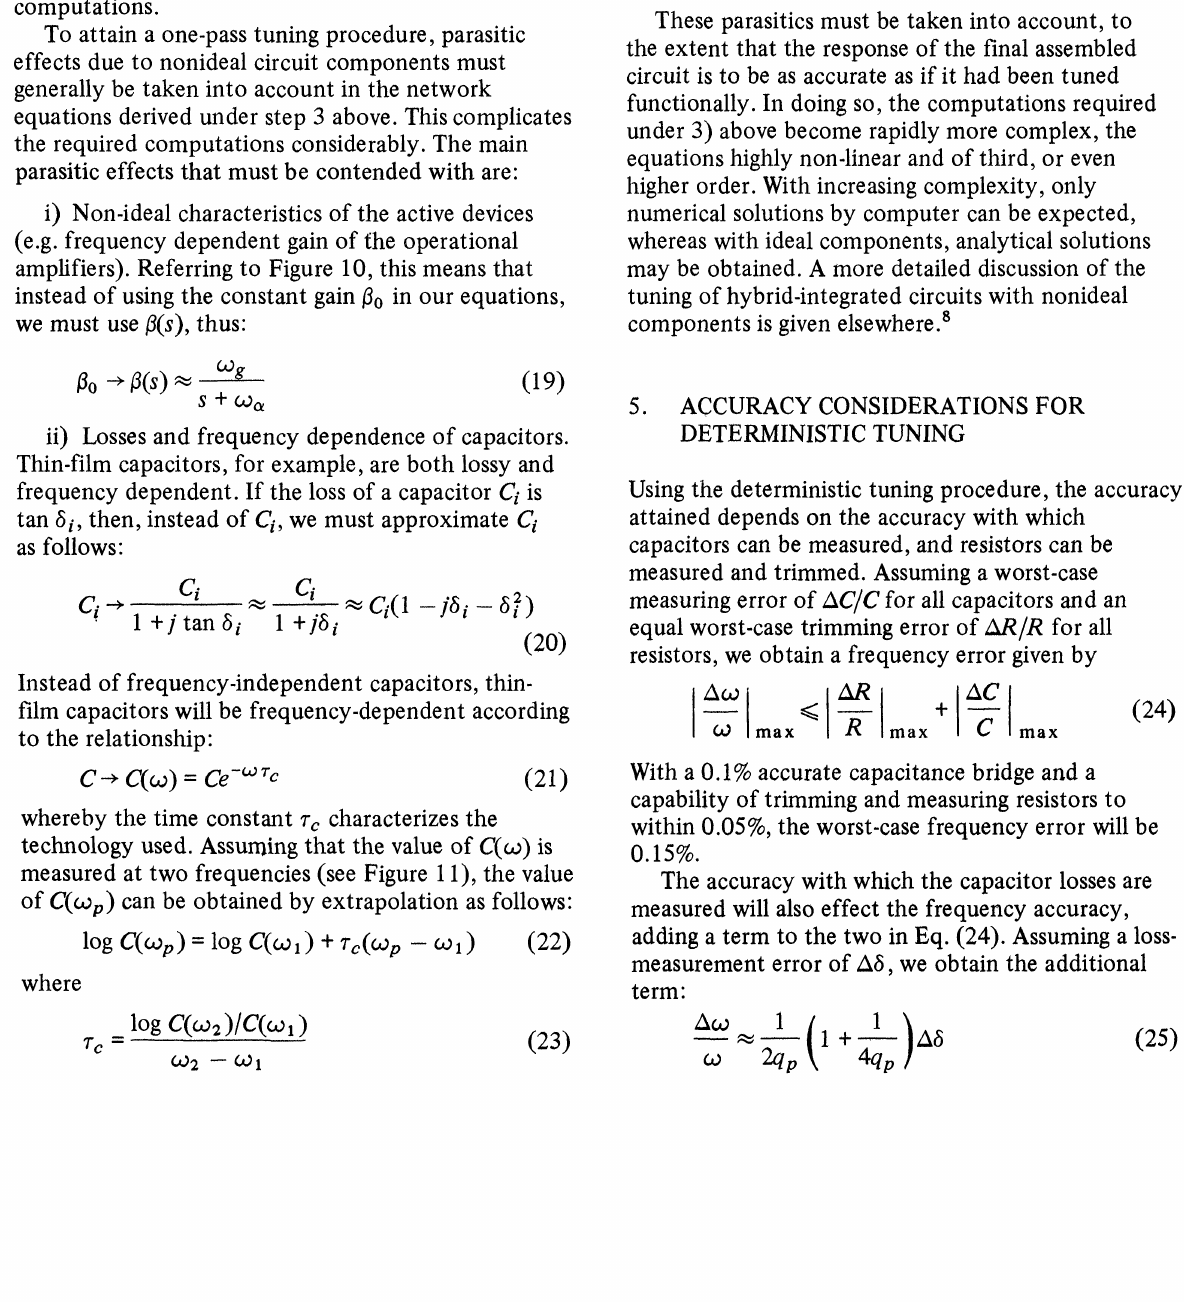
Frequency dependence of a thin-film FIGURE 11 itor.